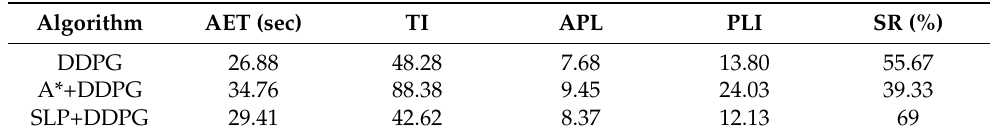
Table 4. Test Case 4 (Large-Scale Dynamic